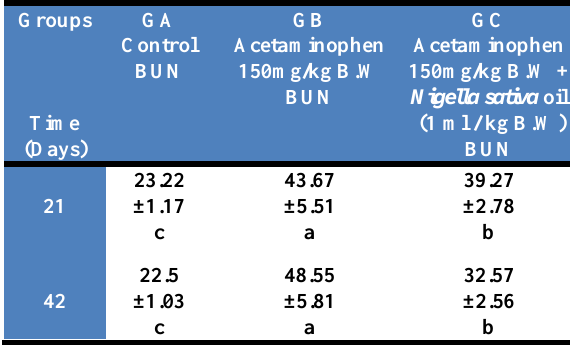
Table, 1: Blood Urea Nitrogen mg/dl concentration in male rats orally in experimental group